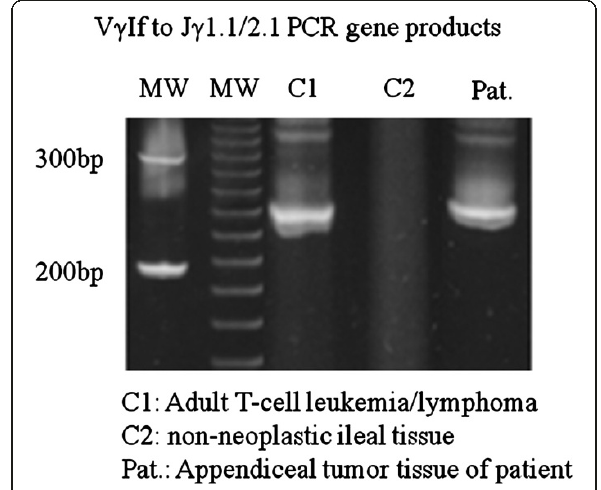
Figure 3 Detection of TCR-V γ 1f to -J γ 1.1/2.1 gene products. C1: nodal adult T-cell leukaemia/lymphoma (positive control); C2: non-neoplastic intestinal specimen (negative control); Pat.: patient sample. The 230 bp clonal band (TCR-V γ to J γ ) is identified in lane C1 and in the patient sample.